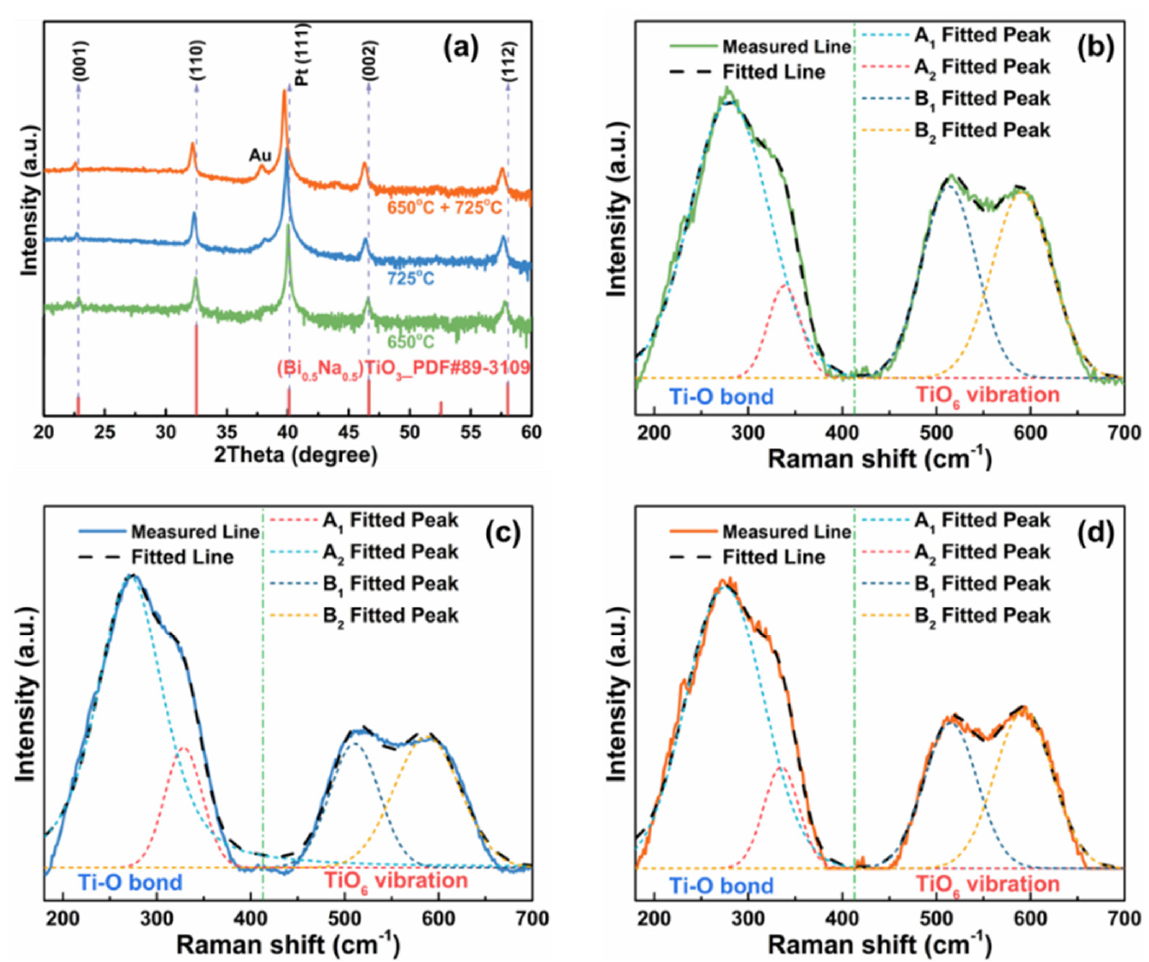
Figure 2. ( a ) X–ray diffraction results of the BNT–5.5BZ samples annealed under different conditions; Raman spectroscopy data with spectral deconvoluted results of the BNT–5.5BZ thin films annealed under different conditions: ( b ) “650 °C”, ( c ) “725 °C”, and ( d ) “650 °C + 725 °C” films.